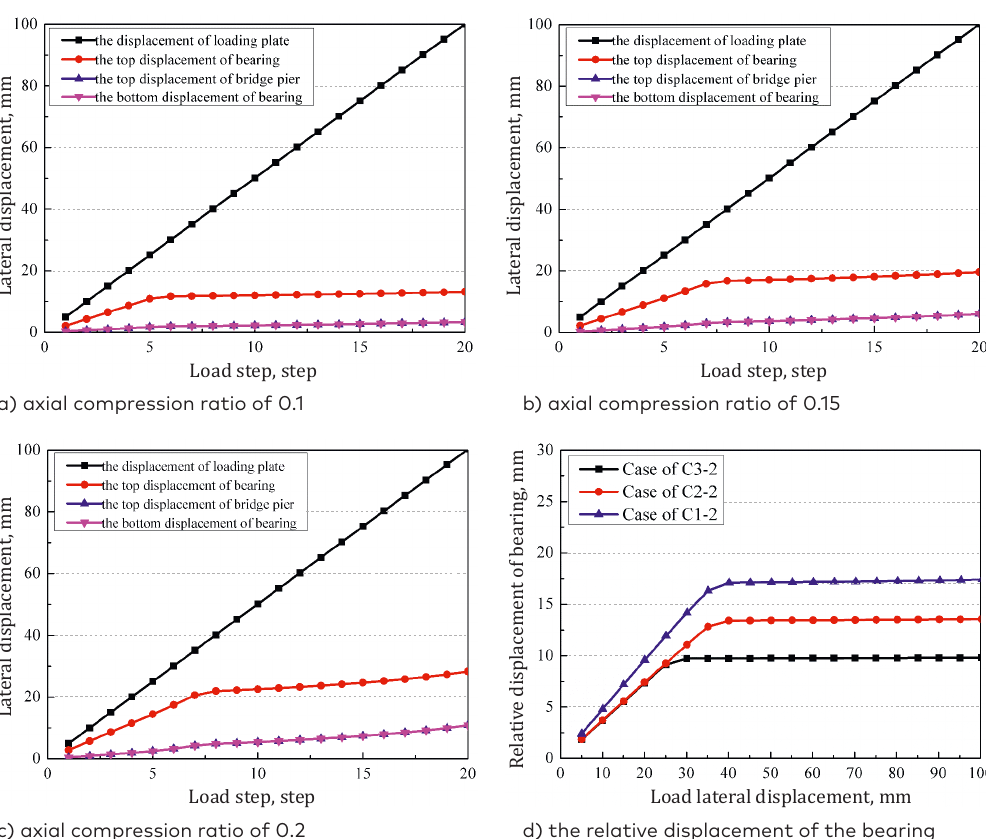
Figure 5. Lateral displacement of the series system with friction coefficient of 0.1 at the upper ends of the bearing